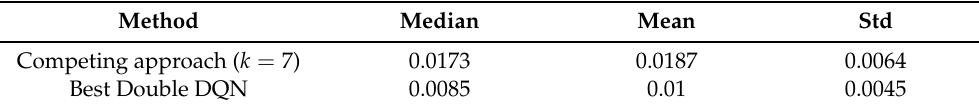
Table 3. Performance comparison for 40 TCLs